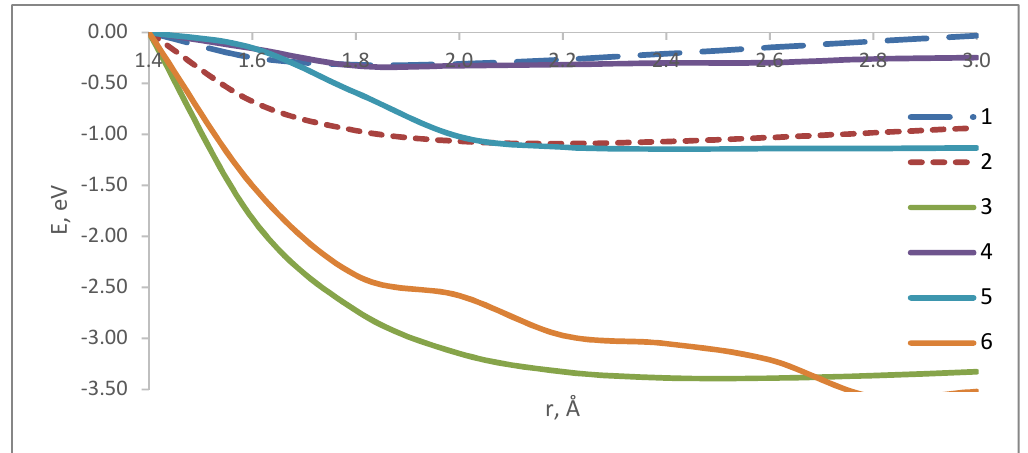
Figure 3. Energy curves of interaction between an amino-group modified nanotube with atoms and ions: 1 Li atom; 2 K atom; 3 Na atom; 4 Li + ion; 5 Na + ion; 6 K + ion, dependent on the distance between atoms/ions of metals and the hydrogen atom of the group. Table 1. The main characteristics of Li, Na, K atom binding to an edge Н atom of an amino group that modifies the nanotube surface: r int —interaction distance between a metal atom and Н atom of the functional group, Е int —a corresponding interaction energy; Q—charges on metal atoms.